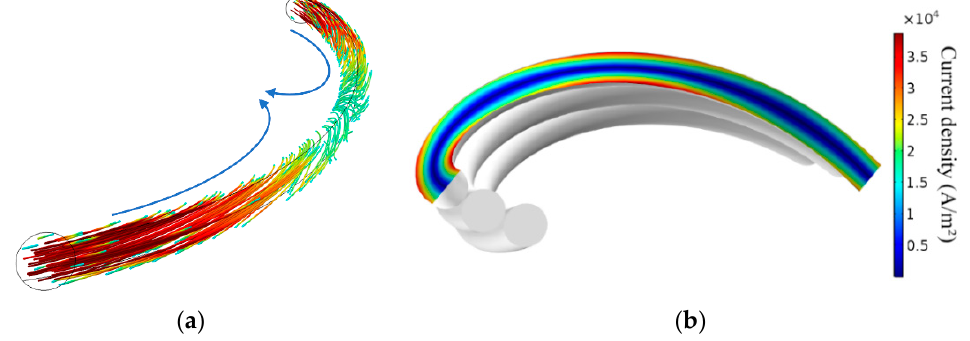
Figure 7. Detailed armor wire in Cable 1: ( a ) Magnetic field flow lines at opposite directions meeting each other and leaving the armor wire; ( b ) Current density distribution in a longitudinal, diametral cross ‐ section in a portion of an armor wire in Cable 1.